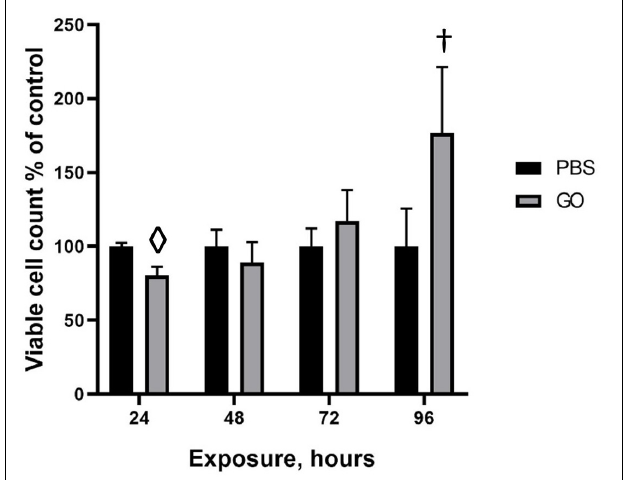
FIGURE 3 | Viability of HepG2 cells in response to GO exposure. To assess the cytotoxic effects of transient exposure of cells to GO-based biomaterials, HepG2 cells were treated with 0.4 µ g GO, GO-EV, or EV and the viability was measured at 24, 48, 72, and 96 h post-treatment. The data depicted represents the mean ± SD; † p < 0. 05, (cid:5) p < 0.0005, relative to the control